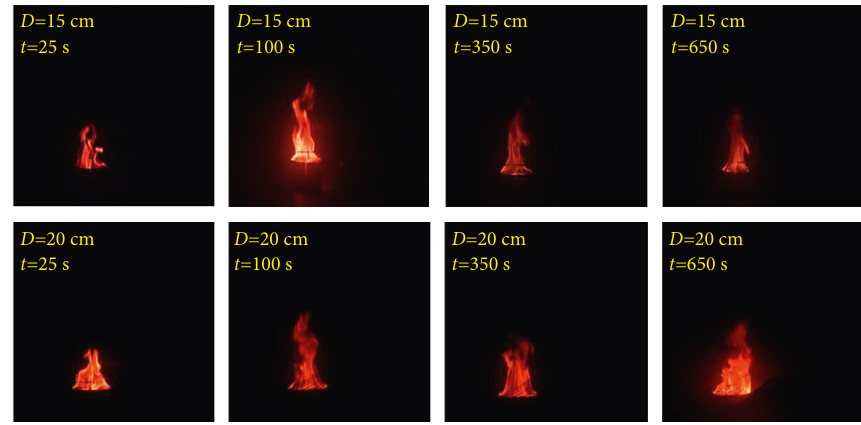
Figure 9: Sequence diagram of flame shape at a typical time in the chamber.